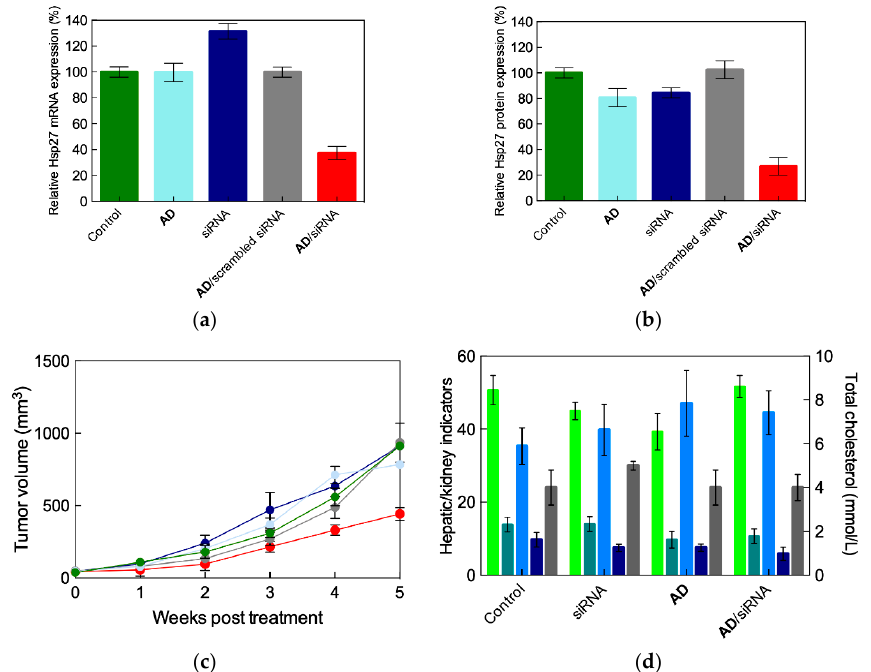
Figure 12. In vivo effective gene silencing of Hsp27 at the mRNA ( a ) and protein ( b ) levels observed in prostate cancer (PC-3) xenograft mice after treatment with Hsp27 siRNA delivered by AD (3 mg / kg siRNA and AD at N / P = 5, injection twice a week for 5 weeks). Hsp27 mRNA and protein levels were quantified by quantitative reverse transcription polymerase chain reaction (qRT-PCR) and western blotting, respectively. Non-treated mice were used for the control. AD alone, siRNA alone and a scrambled (non-silencing) siRNA sequence delivered by AD were used as negative controls. ( c ) Tumor volume during treatment of PC-3 mice xenografts with siRNA / AD complexes (red symbols), compared with non-treated animals (green), and animals treated by AD alone (light blue), siRNA alone (dark blue), and a scrambled (non-silencing) siRNA sequence delivered by AD (gray symbol) used as negative controls. ( d ) Hepatic enzyme levels (alanine transferase ALT (light green bars), gamma-glutamine transferase γ -GLT (teal bars), (kidney functions (creatinine CRE (mmol / L, sky blue bars), blood urea nitrogen BUN ( µ mol / L, dark blue bars), and cholesterol level in the blood (gray bars, values on the right axis) measured in male C57BL / 6 mice treated with intravenous administration of siRNA / AD (3 mg / kg siRNA and AD at N / P = 5). Untreated mice were used for control. Adapted from [6] with permission of John Wiley and Sons,